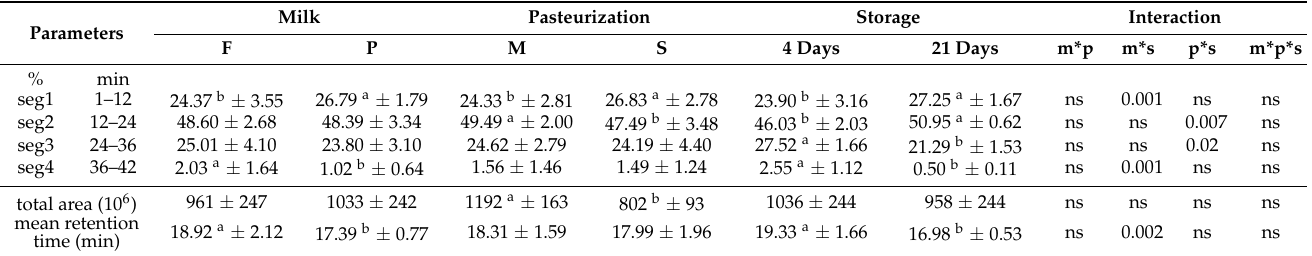
Table 3. Estimated least square means of the area % of each segment (seg), the total area, and the mean retention time of the peptide profile in the digested cheese. Three fixed factors with two levels each were considered: type of milk (F and P), pasteurization level (M and S), and cheese storage (4 days and 21 days) as well as their interactions. F: fresh milk; P: pre-treated milk; M: minimal pasteurization; S: strong